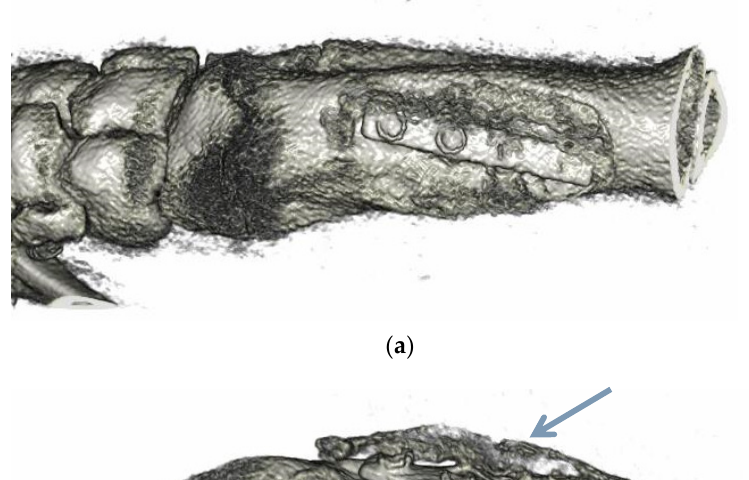
Figure 13. Micro-CT images: ( a ) before and ( b ) after surgery.